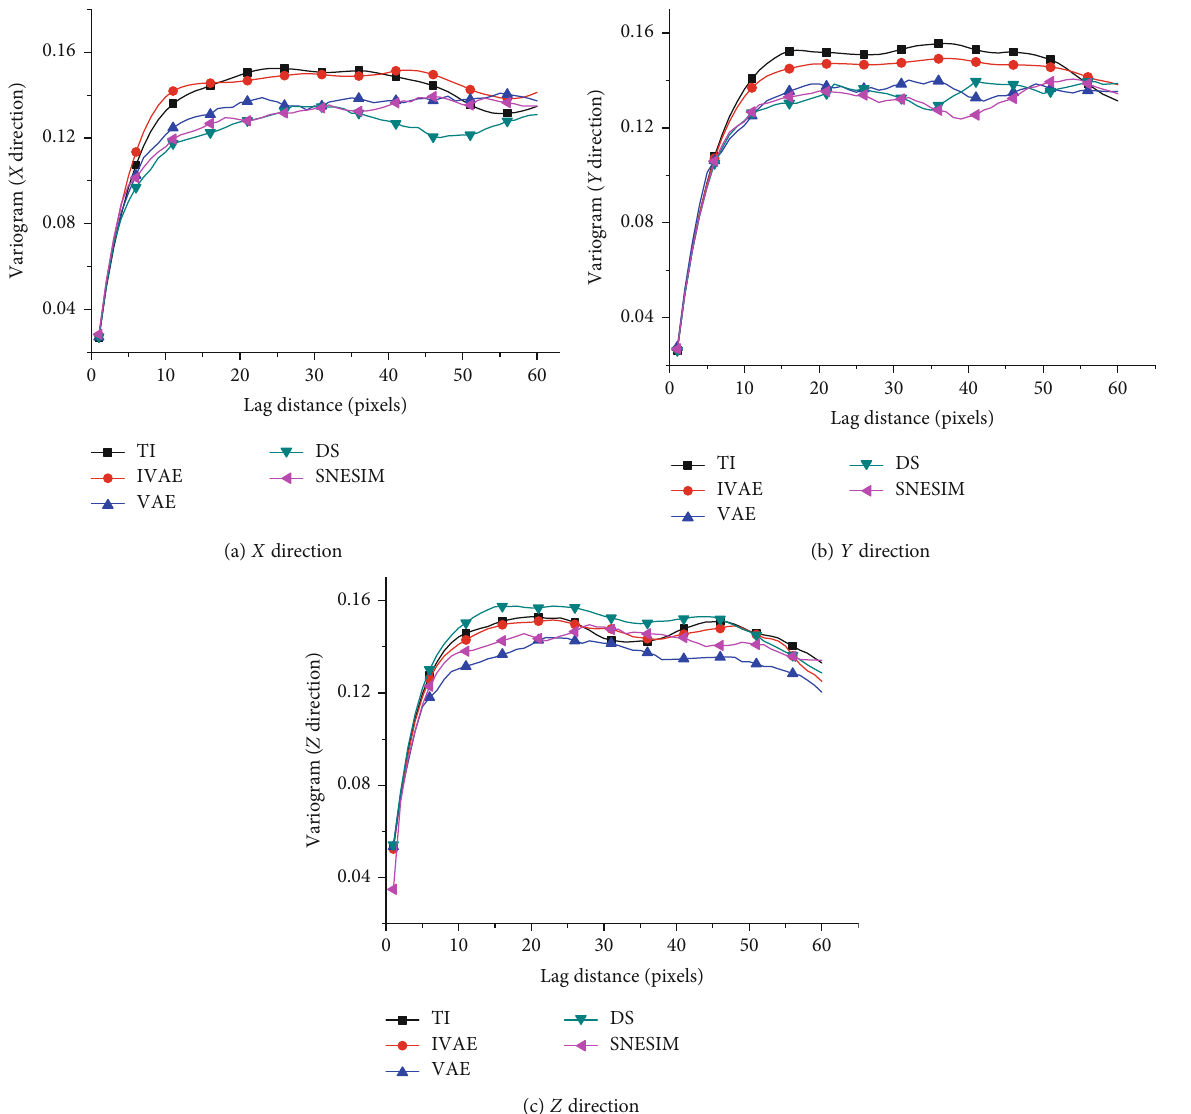
Figure 10: The variogram curves of TI and average variogram curves of 20 reconstructed images by IVAE, SNESIM, VAE, and DS in three